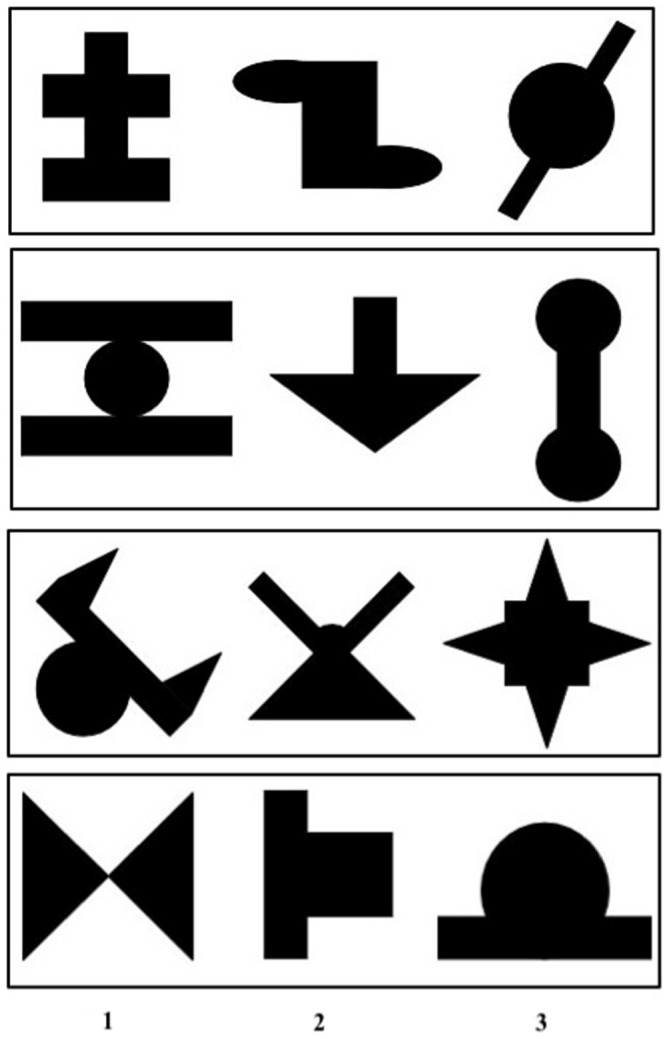
Triplets.Groups of three shapes constituting each of the four triplets, by order of presentation (1, 2, 3).